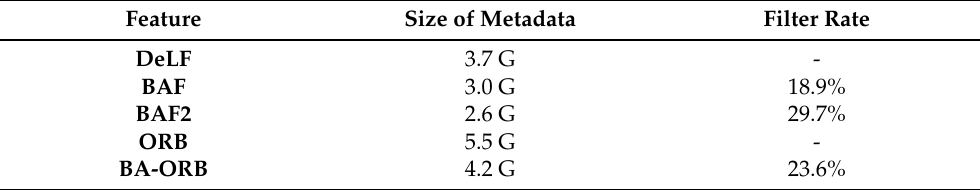
Table 8. Metadata of different features and memory size decrease after building-aware